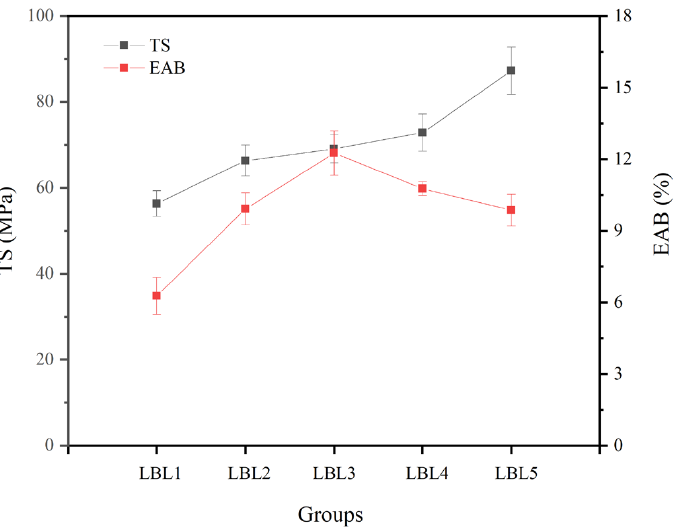
Figure 3. Effect of multilayer on tensile strength (TS) and elongation at break (EAB) of the films.